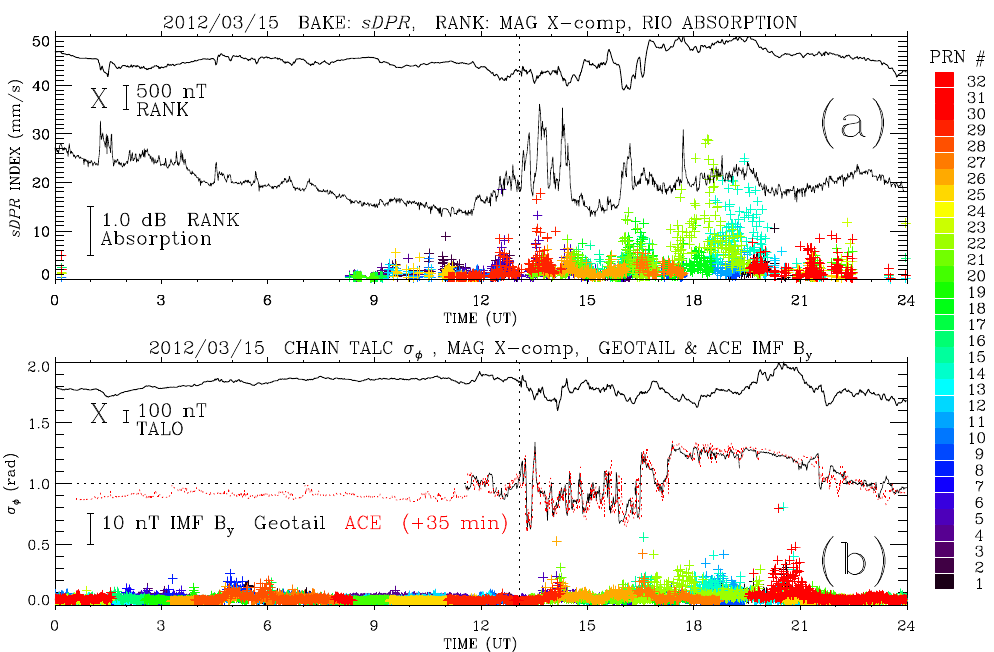
Figure 14. (a) The phase scintillation proxy index sDPR (colored crosses) for elevations above 30 ◦ at Baker Lake, the X component of the ground magnetic field, and the riometer absorption observed in Rankin Inlet. (b) The phase scintillation σ (cid:56) from a GPS receiver and the X component of the ground magnetic field observed in Taloyoak. Superposed is the IMF B y (GSE) observed by Geotail after it crossed the dawnside bow shock exiting from the magnetosheath into the solar wind and ACE (shifted by 35min) in the upstream solar